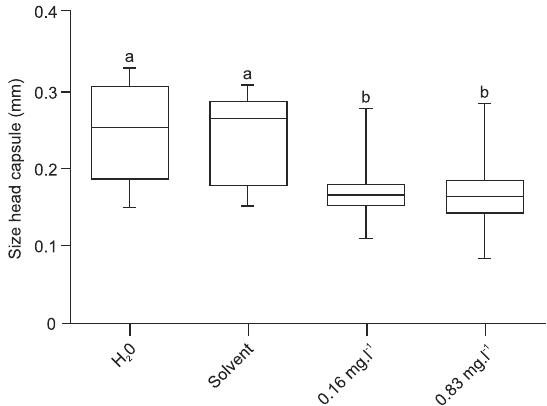
Figure 3. Size of the head capsule of C. sancticaroli larvae demon- strating the average, range minimum and maximum and standard deviation for control groups (water and solvent) and groups